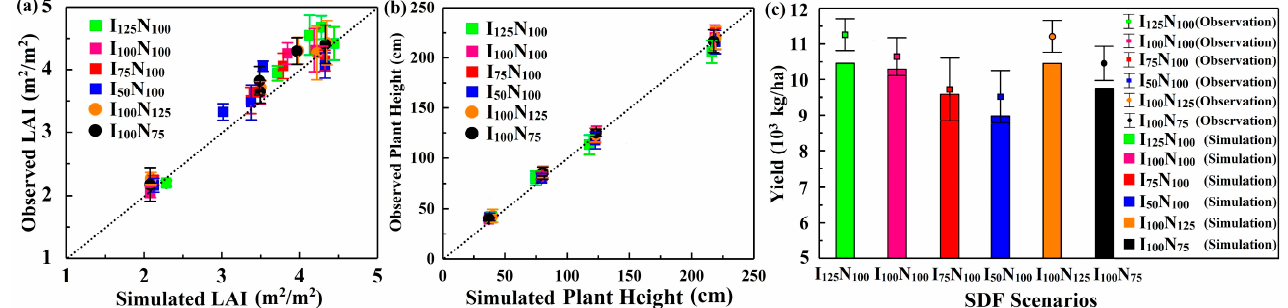
Figure 3. The simulated versus observed LAI ( a ), plant height ( b ) and maize yield ( c ) under six SDF scenarios. The error bars of the observed LAI, plant height and yield were in the range of 2.0–12.0%, 2.1–15.1% and 4.0–9.1%, respectively. Other notations used in this figure are the same as those in